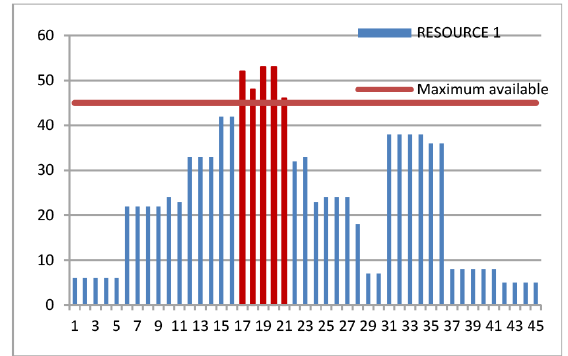
Figure 30. Daily usage of resource 1 throughout the calendar of the project (before using the method)-Experiment